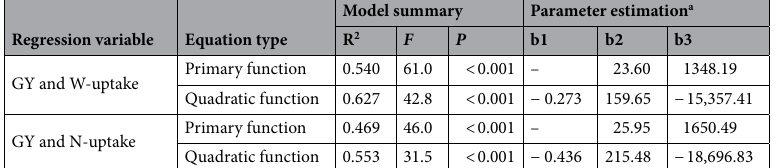
Table 5. Regression of grain yield (GY) with nitrogen uptake (N-uptake) and water uptake (W-uptake) of spring wheat at Wuwei Experimental station across 2016–2018. a b1 is the coefficient of quadratic term, b2 is the coefficient of primary term, and b3 is the constant